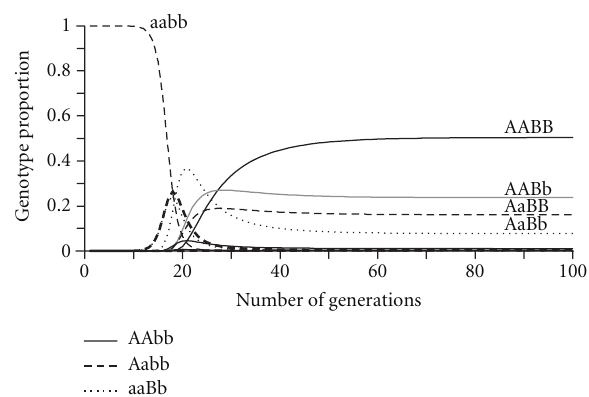
Figure 4: Change in proportions of the nine genotypes during 100 generations (example 4) with indiscriminate mating in which there were initially about 10 7 (0.9999998 aabb) individuals and initially one mutation of a to A (0.0000001 Aabb) and one of b to B (0.0000001 aaBb) resulting in 0.5037 AABB, 0.2376 AABb, and 0.1614 AaBB. Relative survival of each genotype was S 1 = 0.8 (AABB), S 2 = 0.9 (AABb), S 3 = 0.4 (AAbb), S 4 = 0.9 (AaBB), S 5 = 1 (AaBb), S 6 = 0.5 (Aabb), S 7 = 0.1 (aaBB), S 8 = 0.5 (aaBb), and S 9 = 0.2